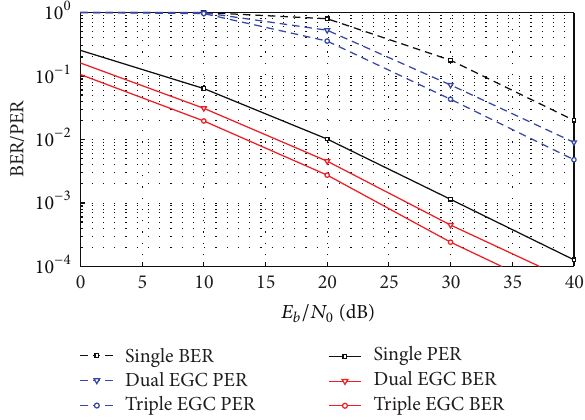
Figure 7: The BER and PER performances using EGC in the PS 3D multipolarized multipath Rician fading channel.